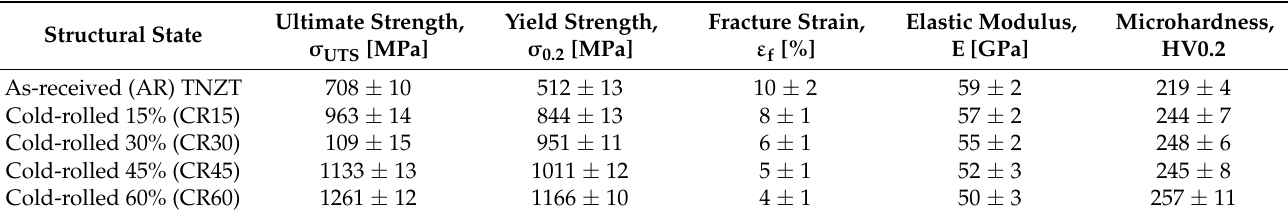
Table 2. Mechanical characteristics of AR and CR TNZT